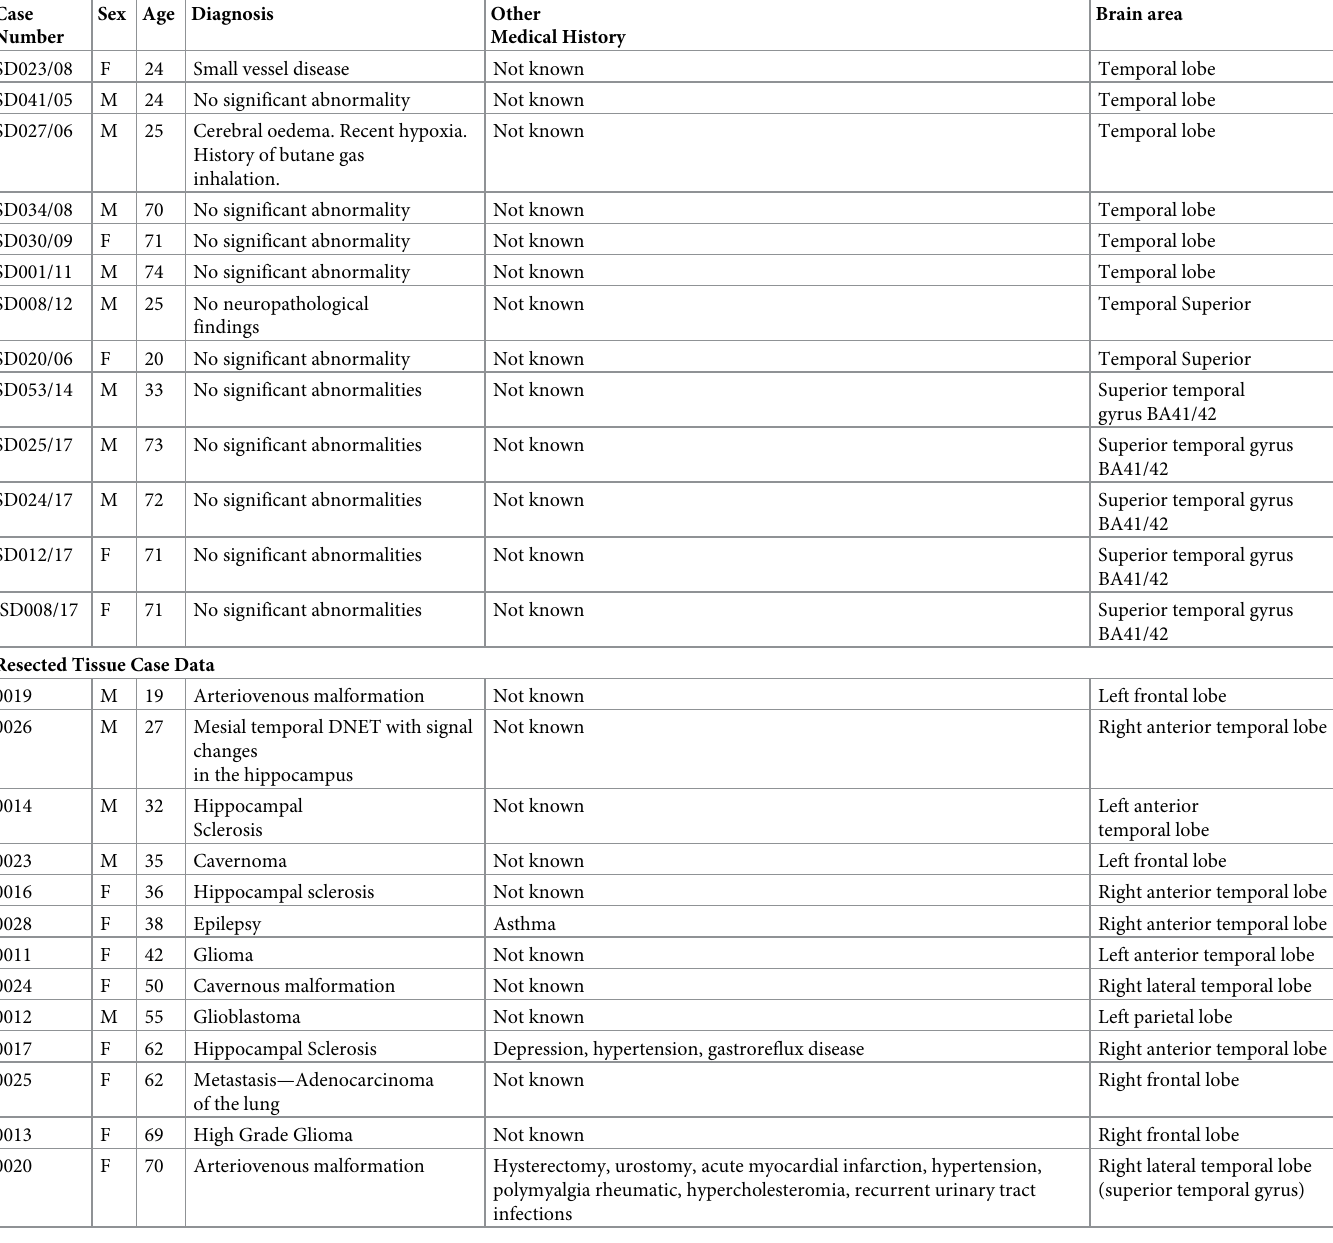
Table 1. Case study details of the human post-mortem brain and surgically resected tissues. Post-mortem brain tissues were obtained from the Sudden Death Brain Bank and divided into young (20 to 33 years) and old (70 to 74 years) cohorts. There was no significant difference in the post-mortem intervals between the young and old cohorts (p = 0.48). Age-matched resected tissues (19 to 70 years) were collected from the Southampton General Hospital. Neuropathological abnormalities were found in cases 0011 and 0020 but no neurodegenerative changes were detected in any of the human